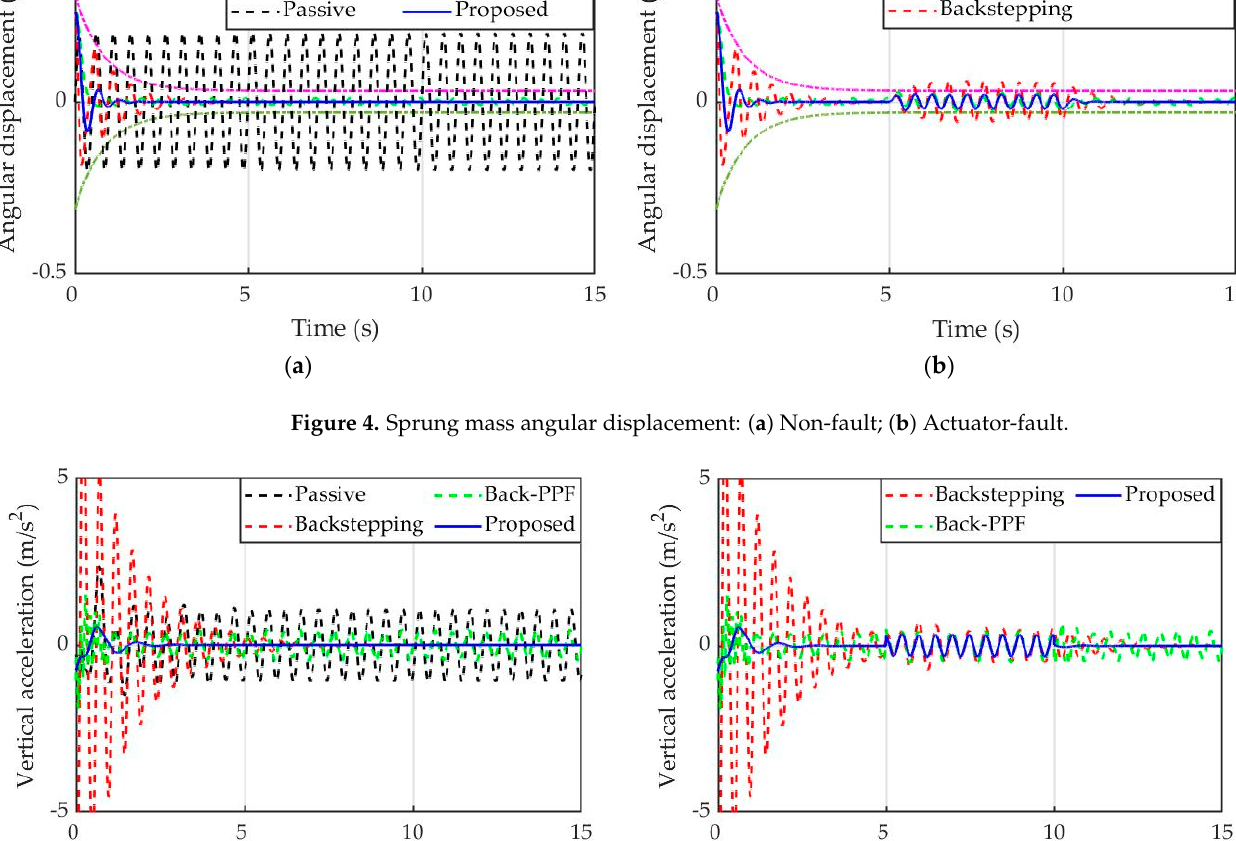
Figure 6. Sprung mass angular acceleration: ( a ) Non-fault; ( b ) Actuator-fault.